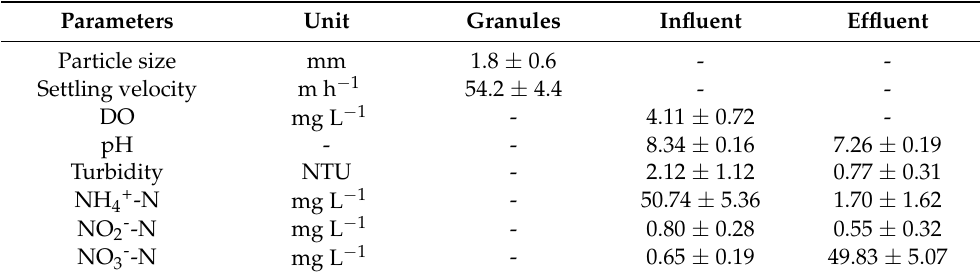
Table 2. Characteristics of seed granule and seed ALR without membrane.